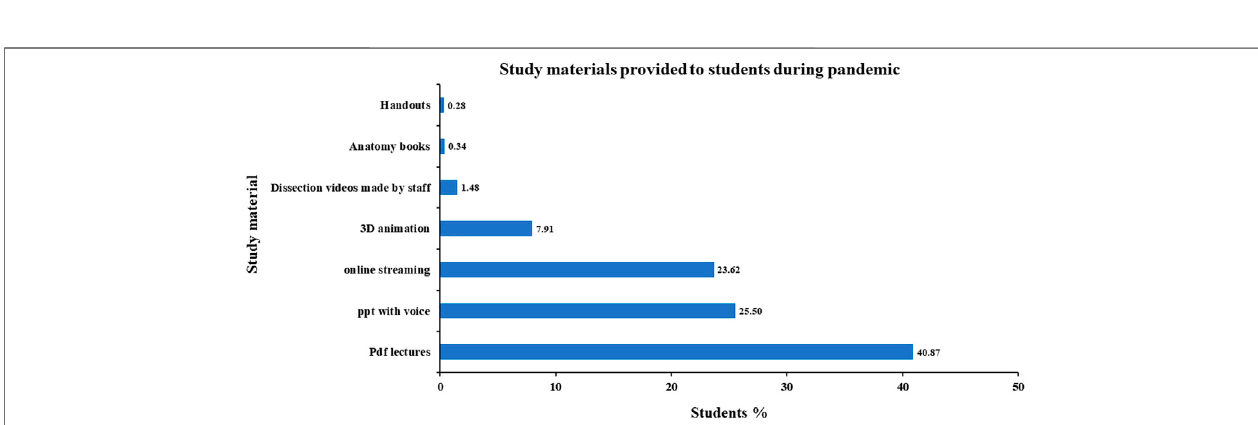
FIGURE 2 | A diagram showing the type of study material provided to